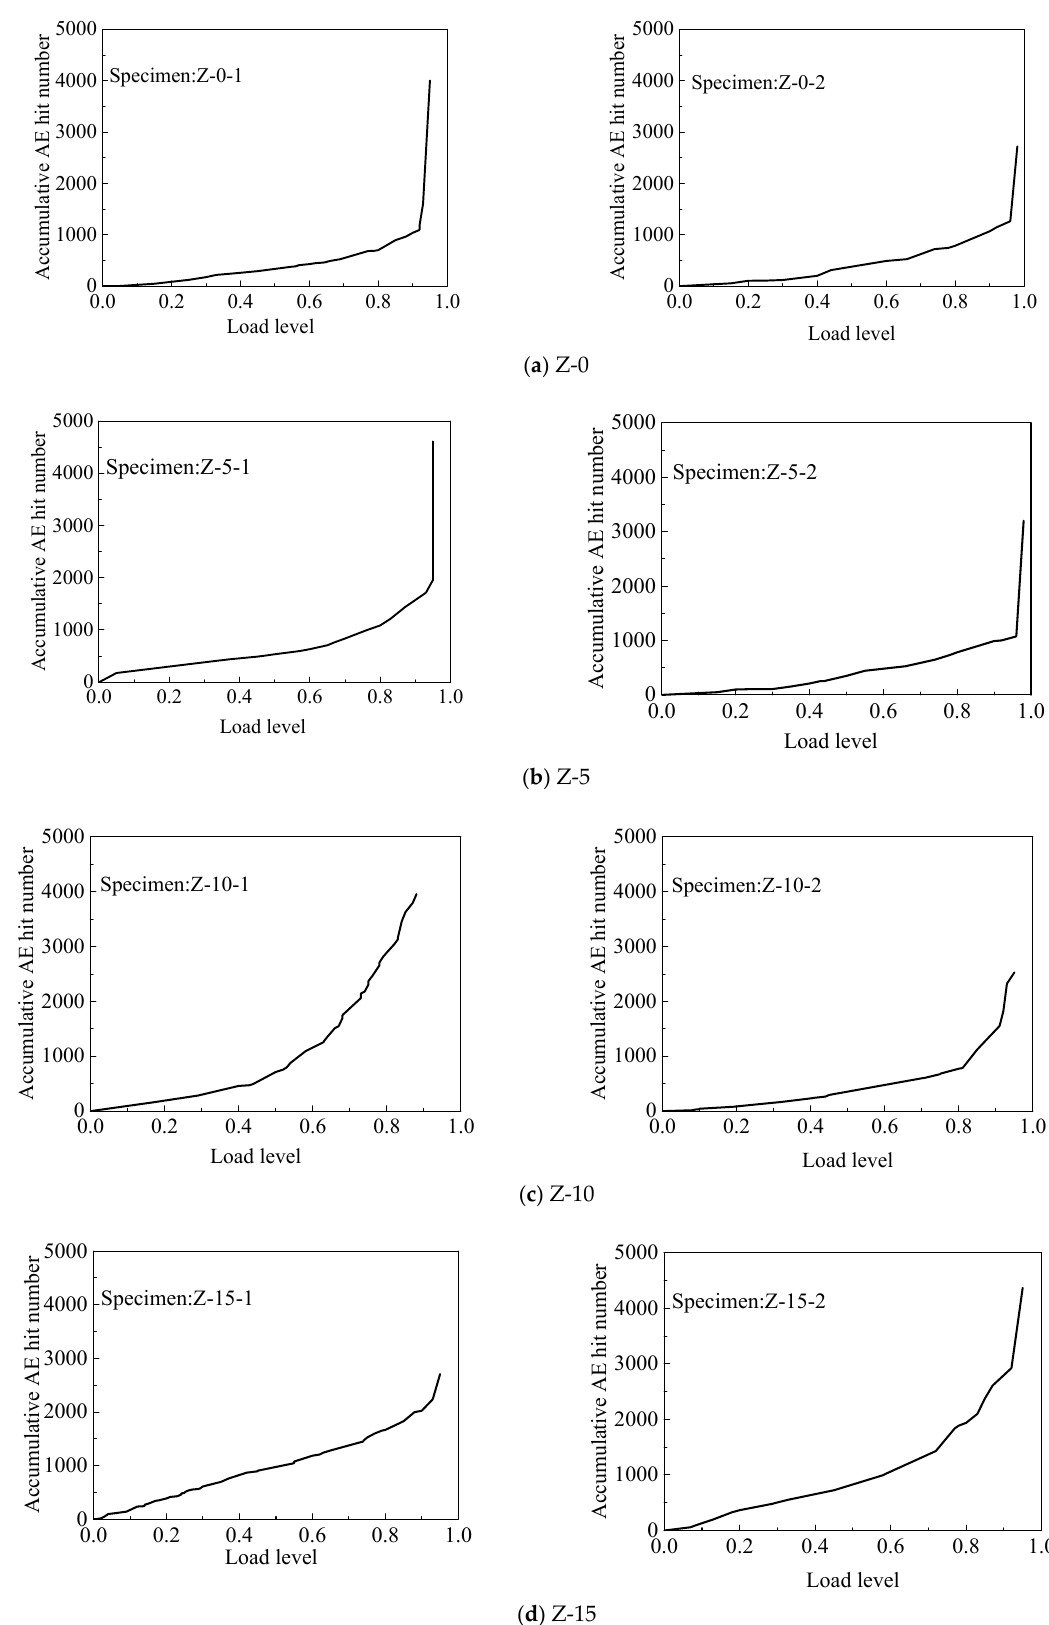
Figure 5. Correlation curve of the acoustic emission (AE) accumulative hit number and load for different corrosion rates